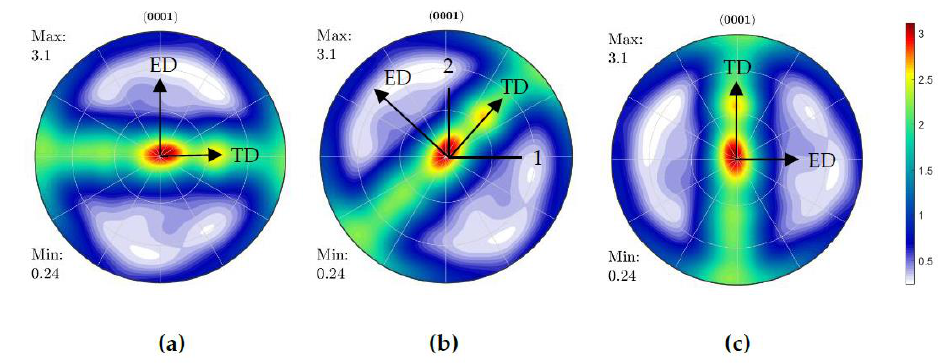
Figure 3. The initial pole figure of the {0001} plane of different samples: ( a ) T0 sample, ( b ) T45 sam- ple, ( c ) T90 sample.